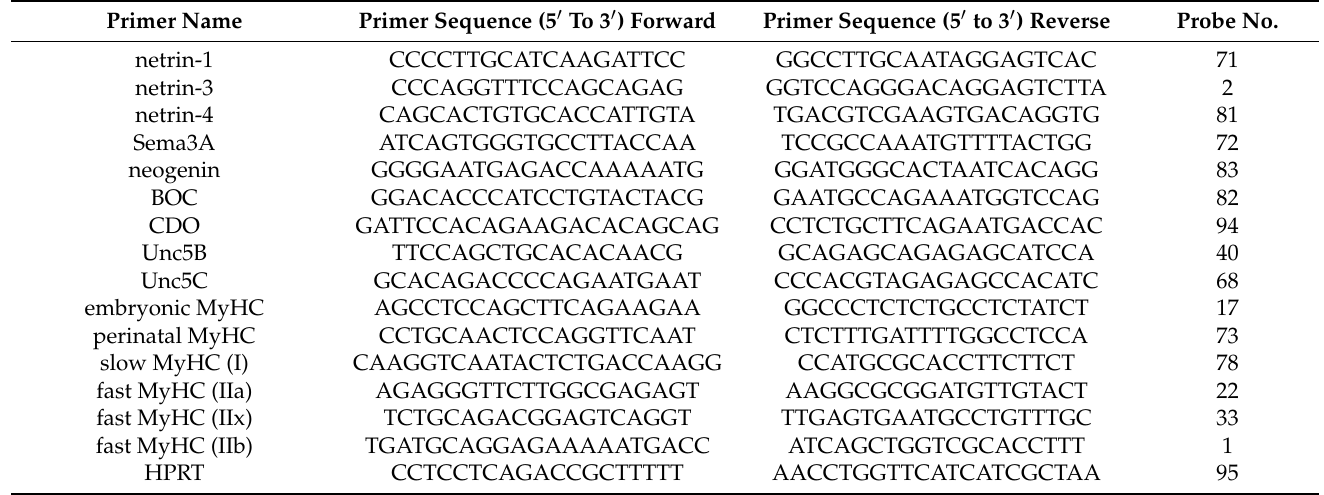
Table 2. Real-time RT-qPCR primer sets for mouse netrins, Sema3A, neogenin, BOC, CDO, Unc5B, Unc5C, MyHCs, and HPRT.